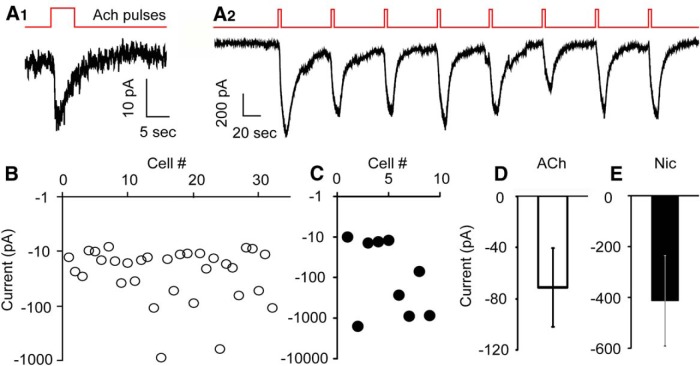
Nicotinic stimulation induced variable inward currents in a third of Hcrt+ neurons. A1, A small, desensitizing current evoked by ACh (1 mM) puff, in the presence of atropine (4 µM). A2, Large, repetitive currents evoked by ACh (1 mM) puff every 60 s. B, In 32 out of 92 Hcrt+ neurons, an ACh (1 mM) puff evoked inward currents of variable size. C, In 9 out of 29 Hcrt+ neurons, a nicotine (Nic; 100 µM) puff evoked inward currents of variable size. D, E, Mean sizes of currents evoked by puffing ACh (1 mM; B) or nicotine (100 µM; C), respectively, onto Hcrt+ neurons.